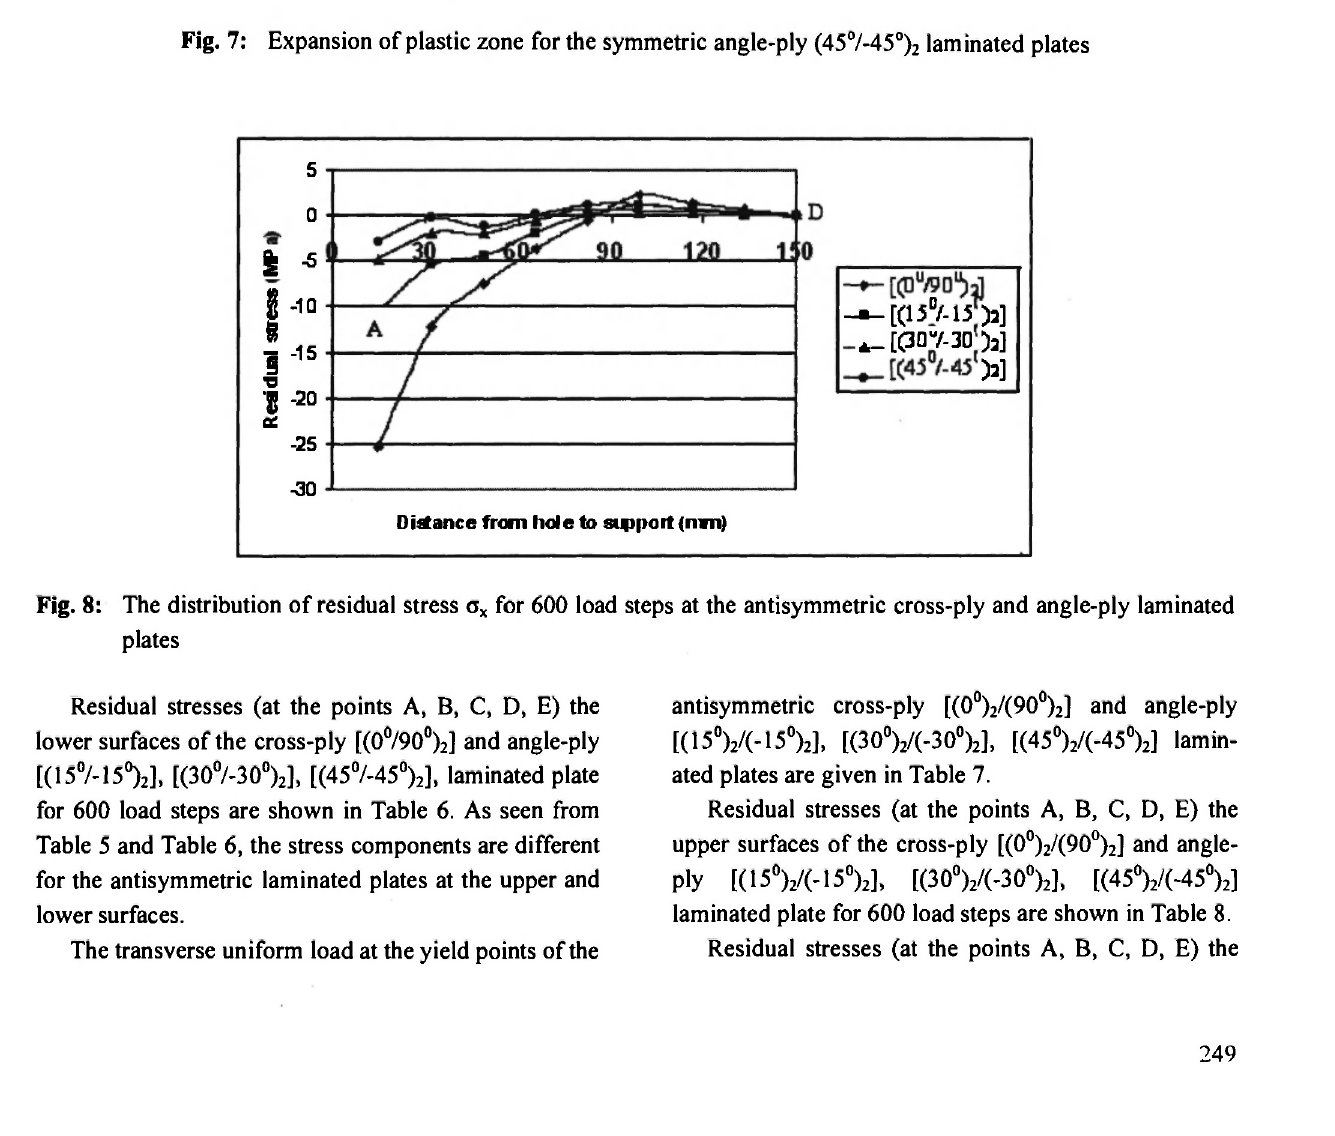
Fig. 7: Expansion of plastic zone for the symmetric angle-ply (45°/-45 0 ) 2 laminated plates